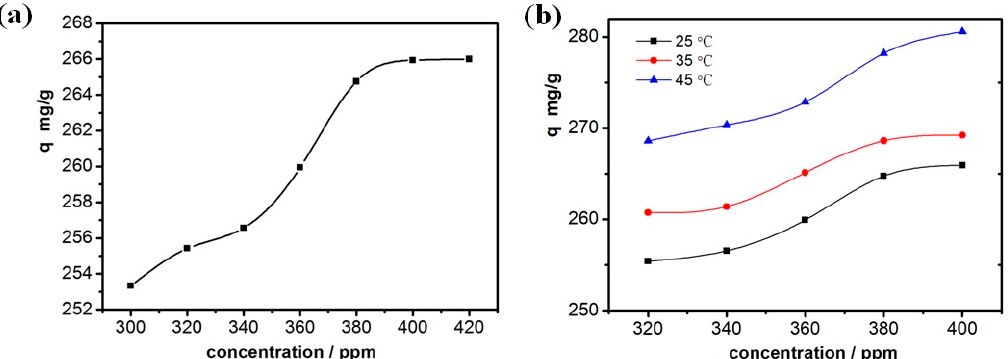
Figure 5. ( a ) The effect of Hg 2+ initial concentration on adsorption quantity ( b ) The adsorption isotherm of Hg 2+ at different temperatures.